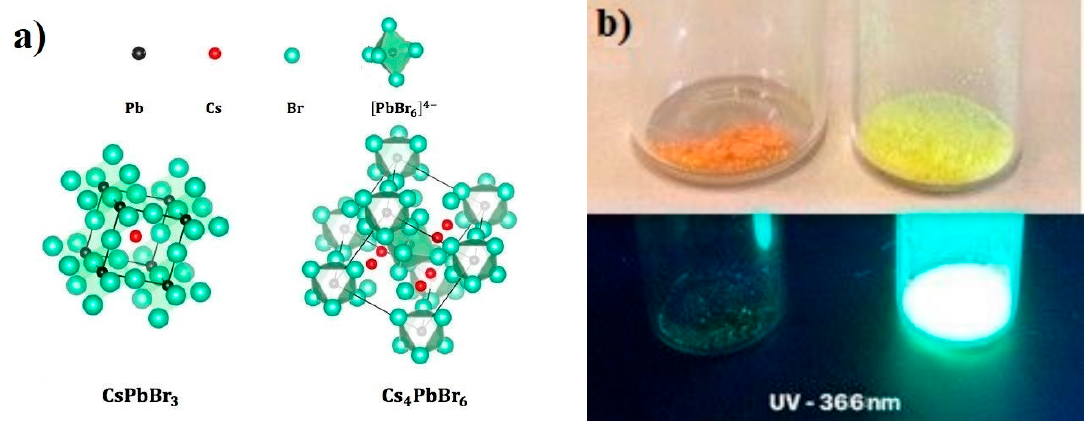
Figure 1. ( a ) Crystal structures of CsPbBr 3 , and Cs 4 PbBr 6 perovskite; ( b ) photos of powders of Cs4PbBr6 orange crystals and DMSO washed Cs 4 PbBr 6 yellow crystals with room light (top) and UV-A light (bottom).